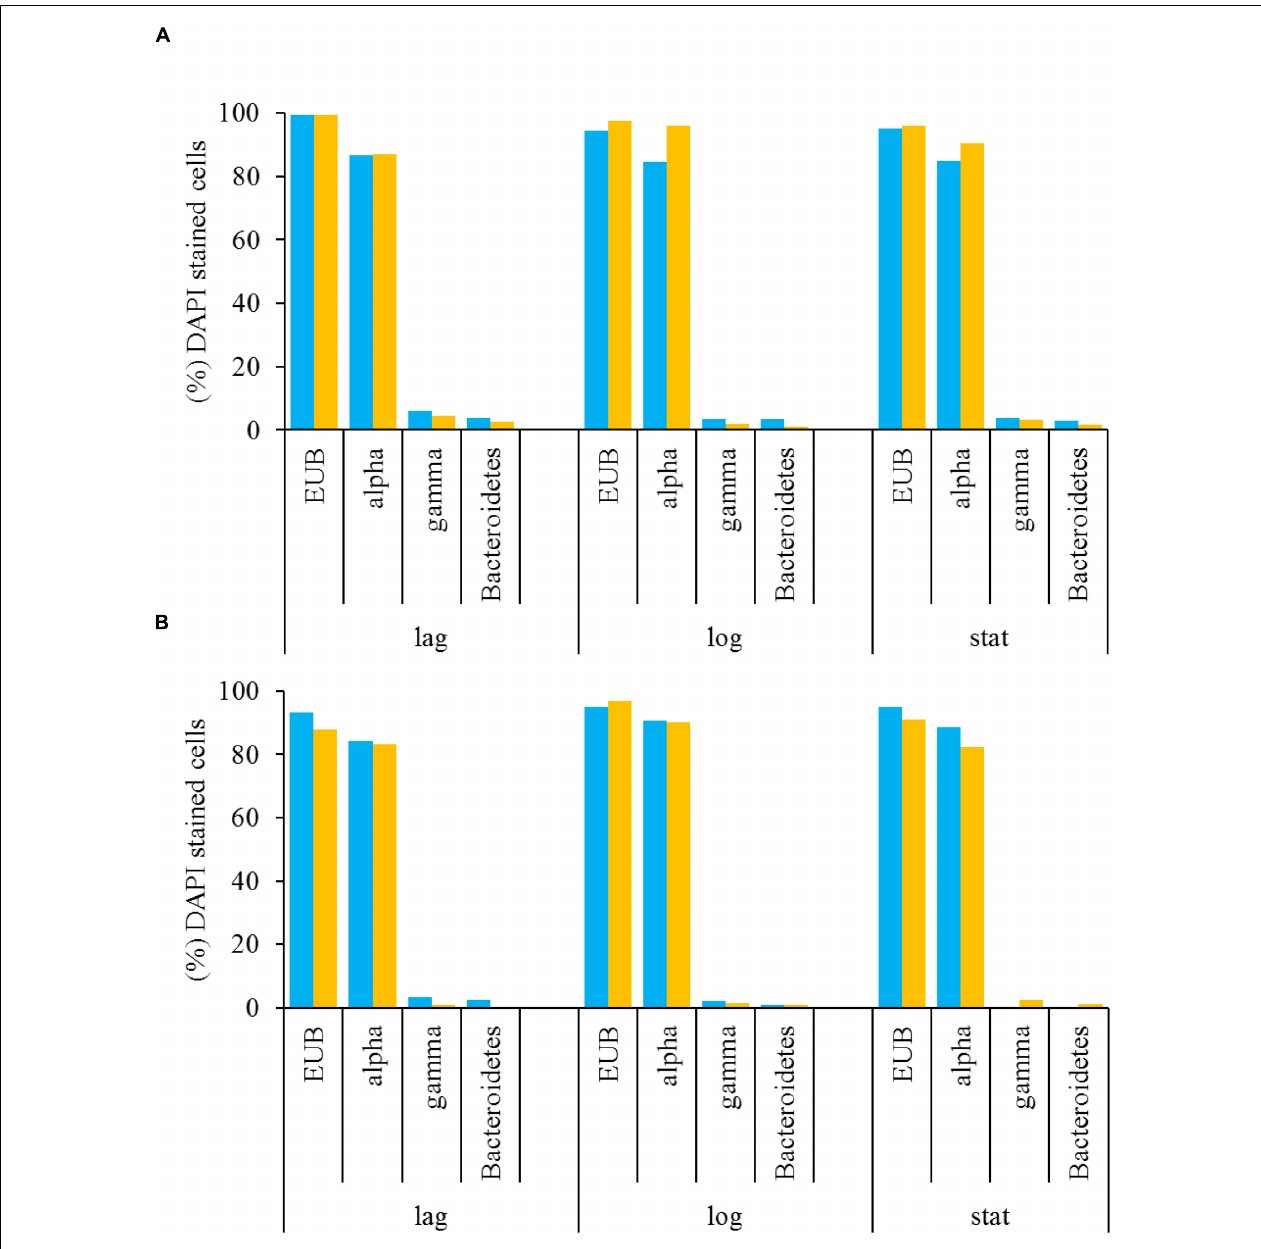
FIGURE 4 | Free-living (A) and attached (B) bacteria associated with L. polyedrum in B-ns ( (cid:4) ) and B-s ( (cid:4) ) cultures during different culture phases (lag, mid-exponential and stationary phases) given in percentages of the total number of DAPI-stained cells. Specific bacterial groups were quantified by FISH hybridized with the four probes listed in Table 1